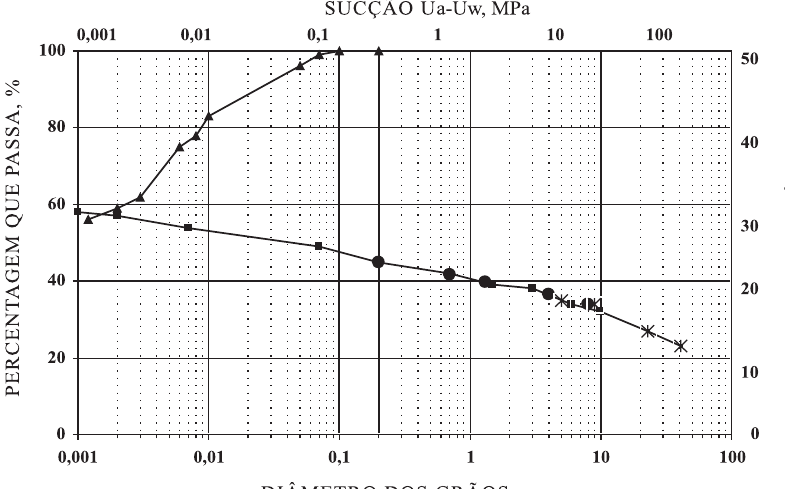
Figura 5. Curvas granulométrica e de retenção de água.